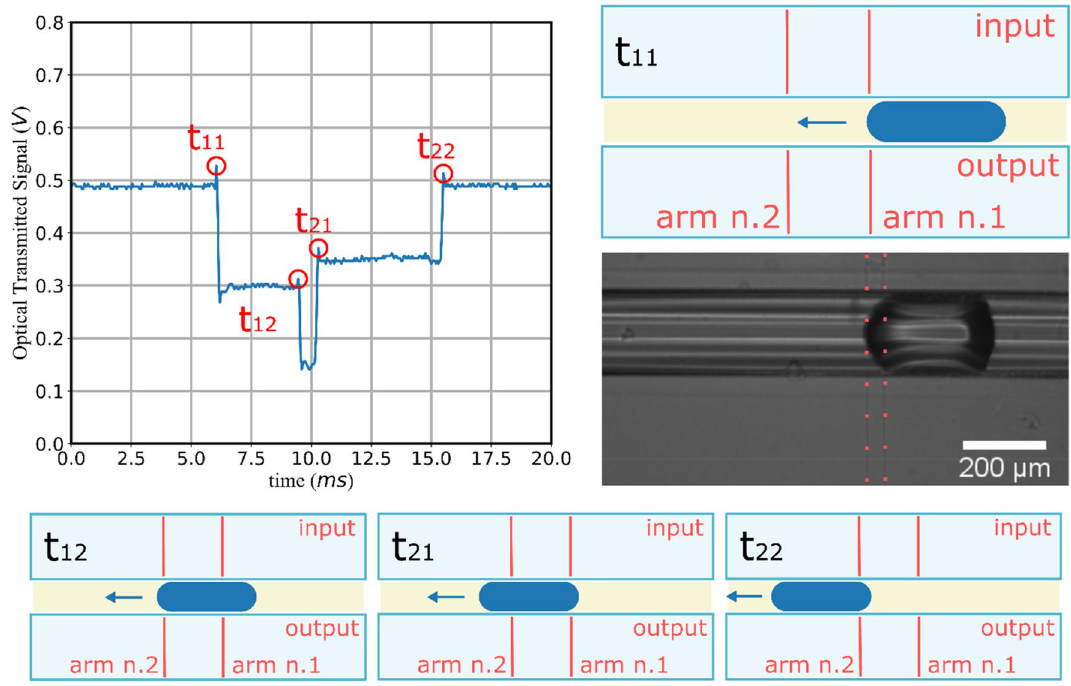
Figure 3. OT signal from the MZI. Example of the OT signal, where the trigger instants have been highlighted; the correspondence between the trigger instants and the droplet position with respect to the MZI waveguides is also illustrated. The picture is captured by the microscope system used as comparison, where the position of the MZI branches during the detection has been highlighted. The picture represents an example of a frame from the imaging system, highlighting the MZI branches during the